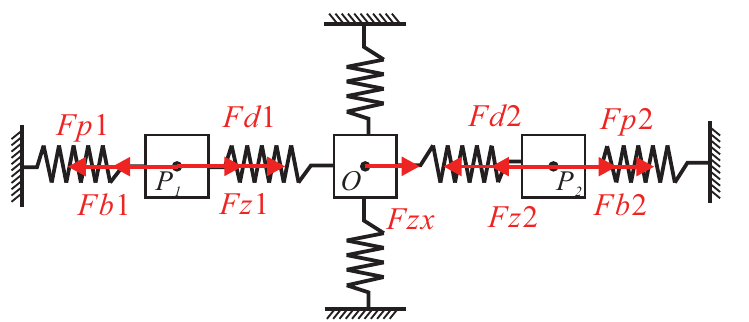
Figure 8. Equivalent rigid body model on the